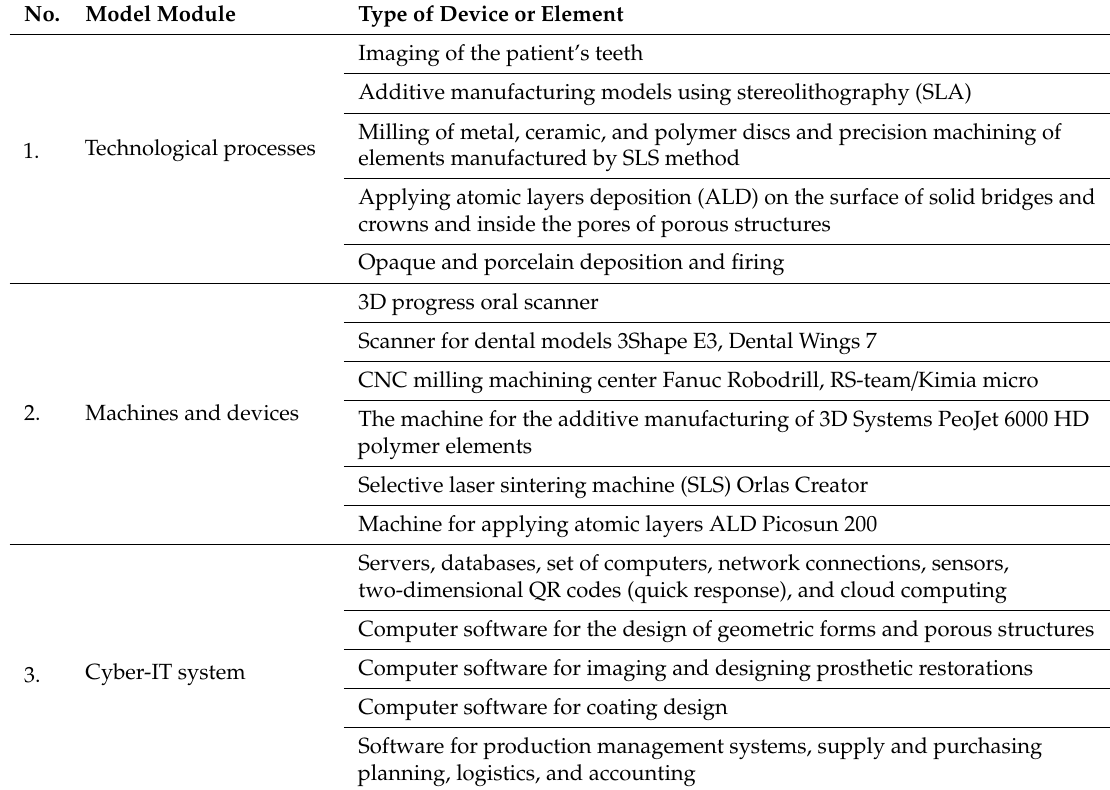
Table 10. Examples of how to meet the requirements contained in the technological platform of the augmented holistic Industry 4.0 model in the case of the authors’ own projects regarding the application of the augmented holistic Industry 4.0 concept at the dental prosthetic restoration center according to idea Dentistry